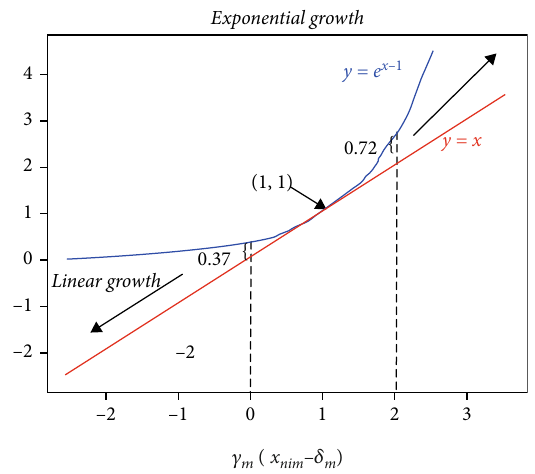
Figure 2: Relationship between adjusted independent variables and the asymmetric di ff erences.